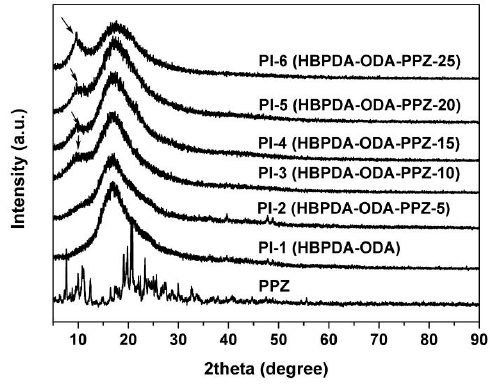
Figure 4. XRD spectra of PPZ (FP-100) and PI films.